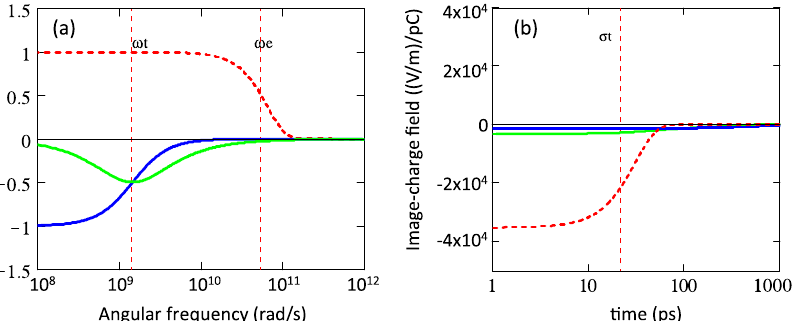
˜ ˜ f ð ω Þ = f ð 0 Þ (red dashed curve) as a function of the angular FIG. 12. (a) The Fourier spectrum of the image field shape function frequency. The edge frequency is shown at ω . The real (blue solid curve) and imaginary (green solid curve) parts of the cathode surface e ð ω Þ . The transition frequency is indicated at ω loss function − g . (b) The real (blue solid curve) and imaginary (green solid curve) parts c t of the image-charge field of the metacathode. The image-charge field per pC for the standard cathode (red dashed curve) is shown for reference. All curves are calculated using the design parameters given in Table